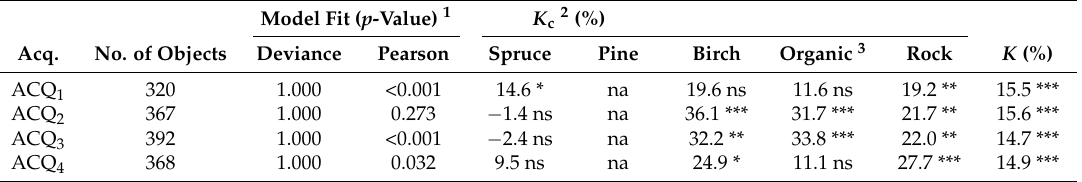
Table 6. Model fit and results of leave-one-out cross validation of the multinomial logistic regression models fitted according to Equation (4). Only objects with at least one echo with h > 0 are included. Model Fit ( p -Value) 1 K c 2 (%) Acq. No. of Objects Deviance Pearson Spruce Pine Birch